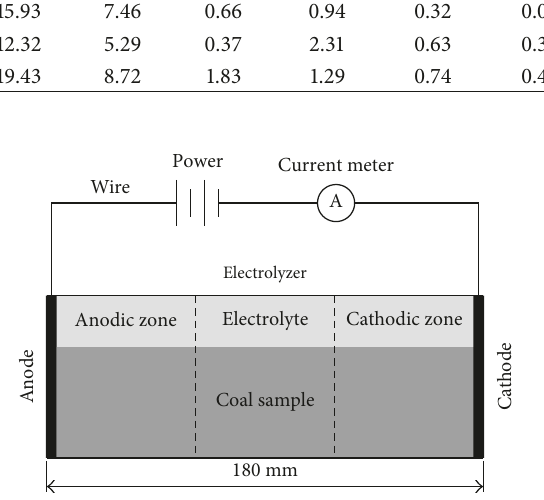
Figure 1: Diagram of the electrochemical modification